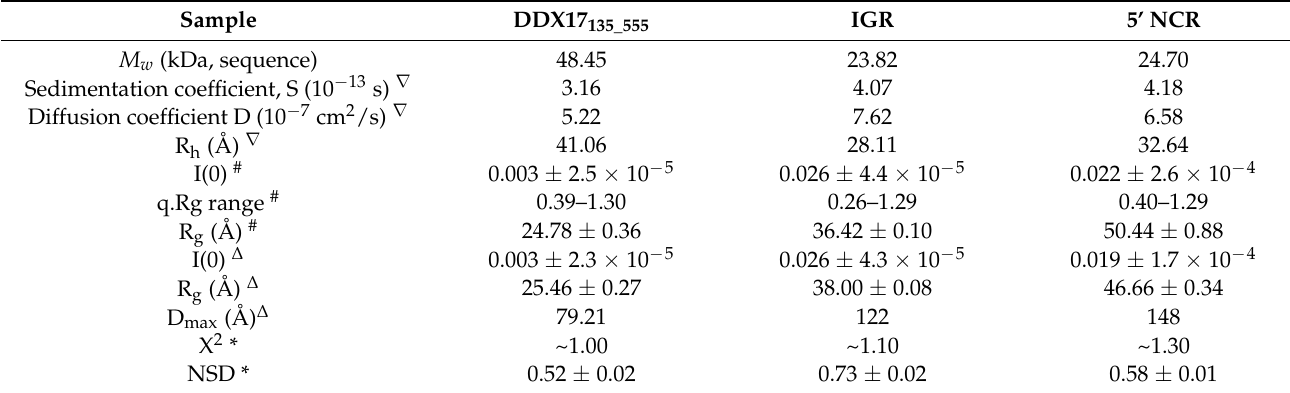
Table 1. Solution properties of DDX17 135–555 , IGR, and 5’